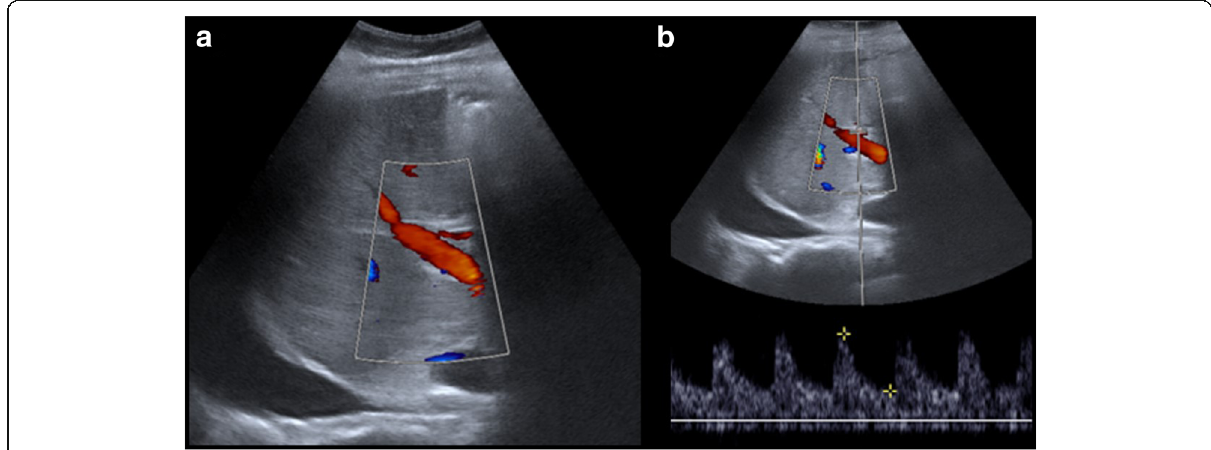
Fig. 1 a , b US control. Postoperative CDUS is performed at 24 h, 48 h, 1 day, and 7 days after surgery. Images show a normal portal and hepatic artery